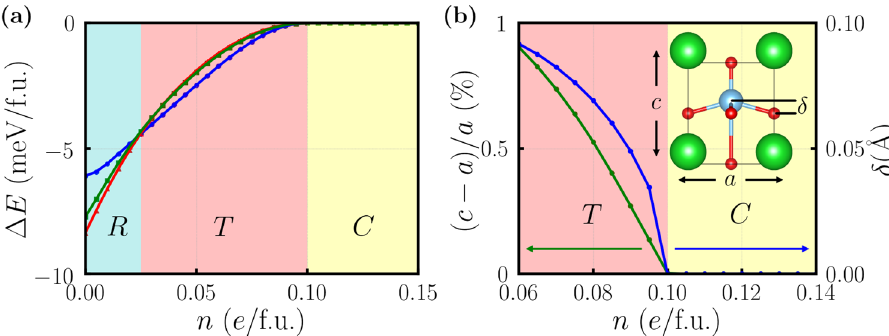
Fig. 1 Structural phase transition of BaTiO 3 induced by electron doping. a Total energies of n -doped BaTiO 3 in different crystal structures: the rhombohedral structure ( R , red line), the orthorhombic structure ( O , green line), the tetragonal structure ( T , blue line) and the cubic structure ( C , setting as the zero point at each electron doping concentration n ). Upon electron doping, the ground state structure of BaTiO 3 changes from R to T , fi nally to C . b The c / a ratio and Ti-O cation displacement δ of n -doped BaTiO 3 . T means the tetragonal structure and C means the cubic structure. The inset shows the tetragonal structure of doped BaTiO 3 where c is the long cell axis and a is the short cell axis. δ is the displacement of the Ti atom with respect to the O atom layer along the structure at a representative concentration ( n = 0.09 e /f.u., close to